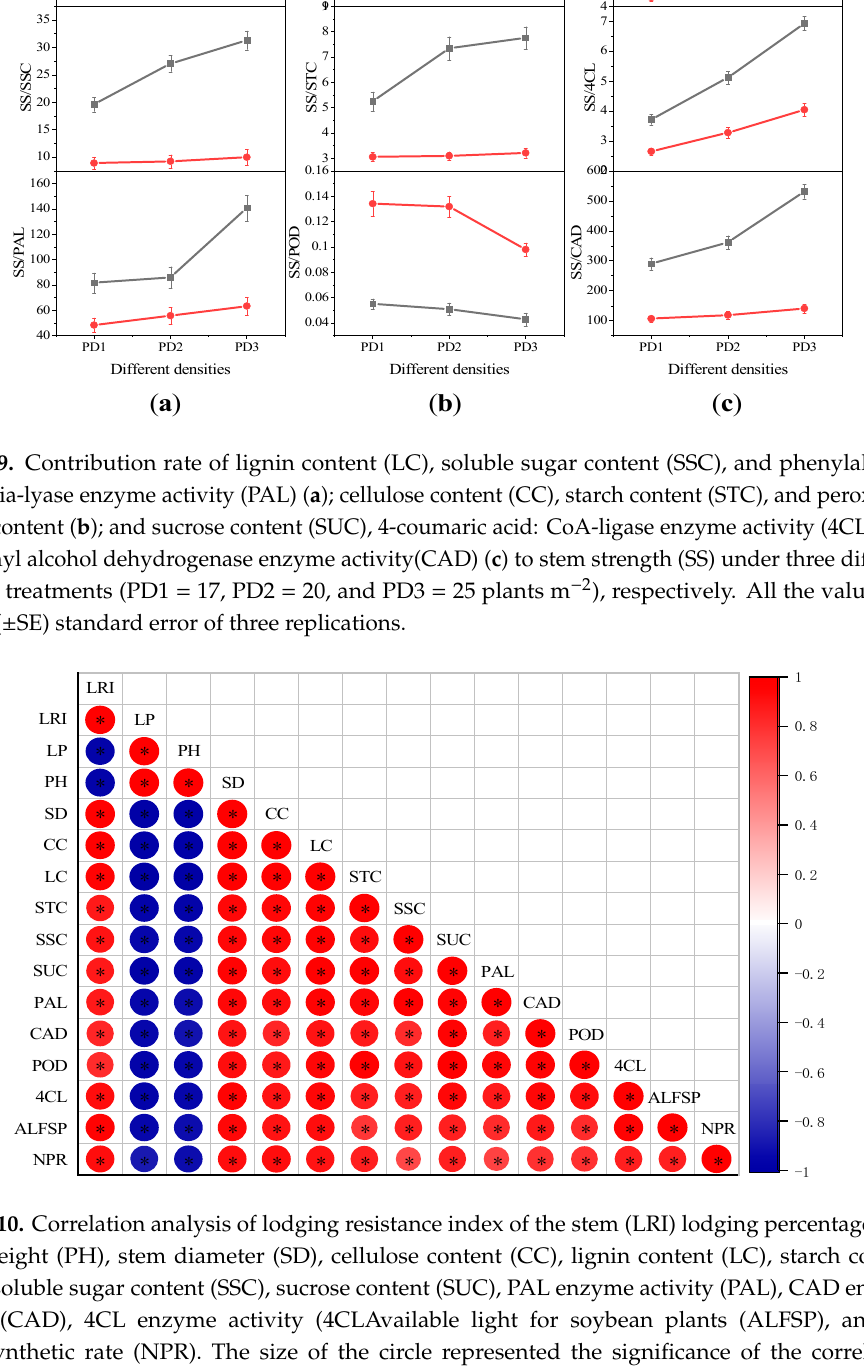
Figure 10. Correlation analysis of lodging resistance index of the stem (LRI) lodging percentage (LP), plant height (PH), stem diameter (SD), cellulose content (CC), lignin content (LC), starch content (STC), soluble sugar content (SSC), sucrose content (SUC), PAL enzyme activity (PAL), CAD enzyme activity(CAD), 4CL enzyme activity (4CLAvailable light for soybean plants (ALFSP), and net photosynthetic rate (NPR). The size of the circle represented the significance of the correlation, and the color of the circle represented the positive or negative correlation. The redder the circle is, the more significant positive correlation is, and the bluer the circle is, the more significant negative correlation is. The significant di ff erence among the di ff erent treatments was displayed by * at probability level p ≤